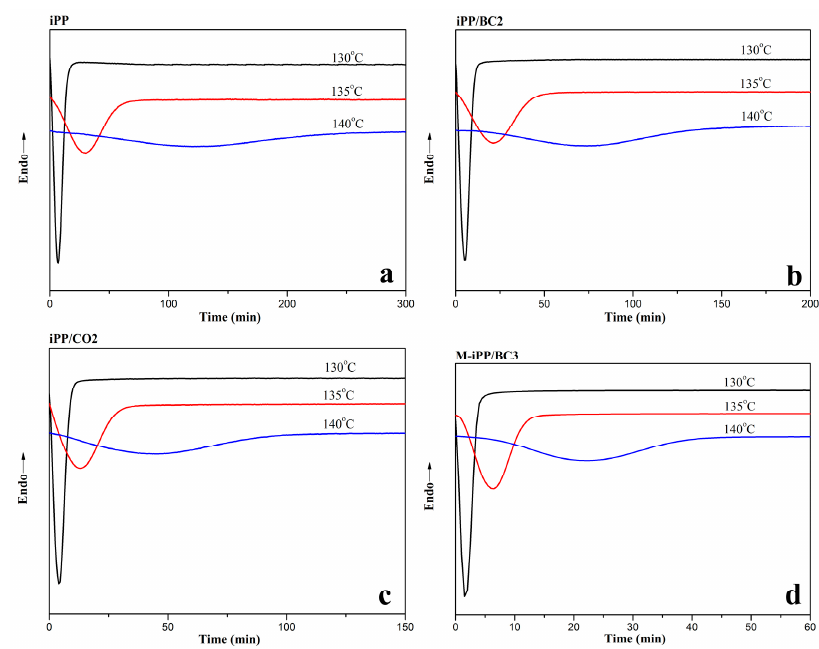
Figure 2. Isothermal crystallization curves of iPP/BC composites at different temperatures. ( a ) iPP ( b ) iPP/BC2 ( c ) iPP/CO2 ( d ) M-iPP/BC3.